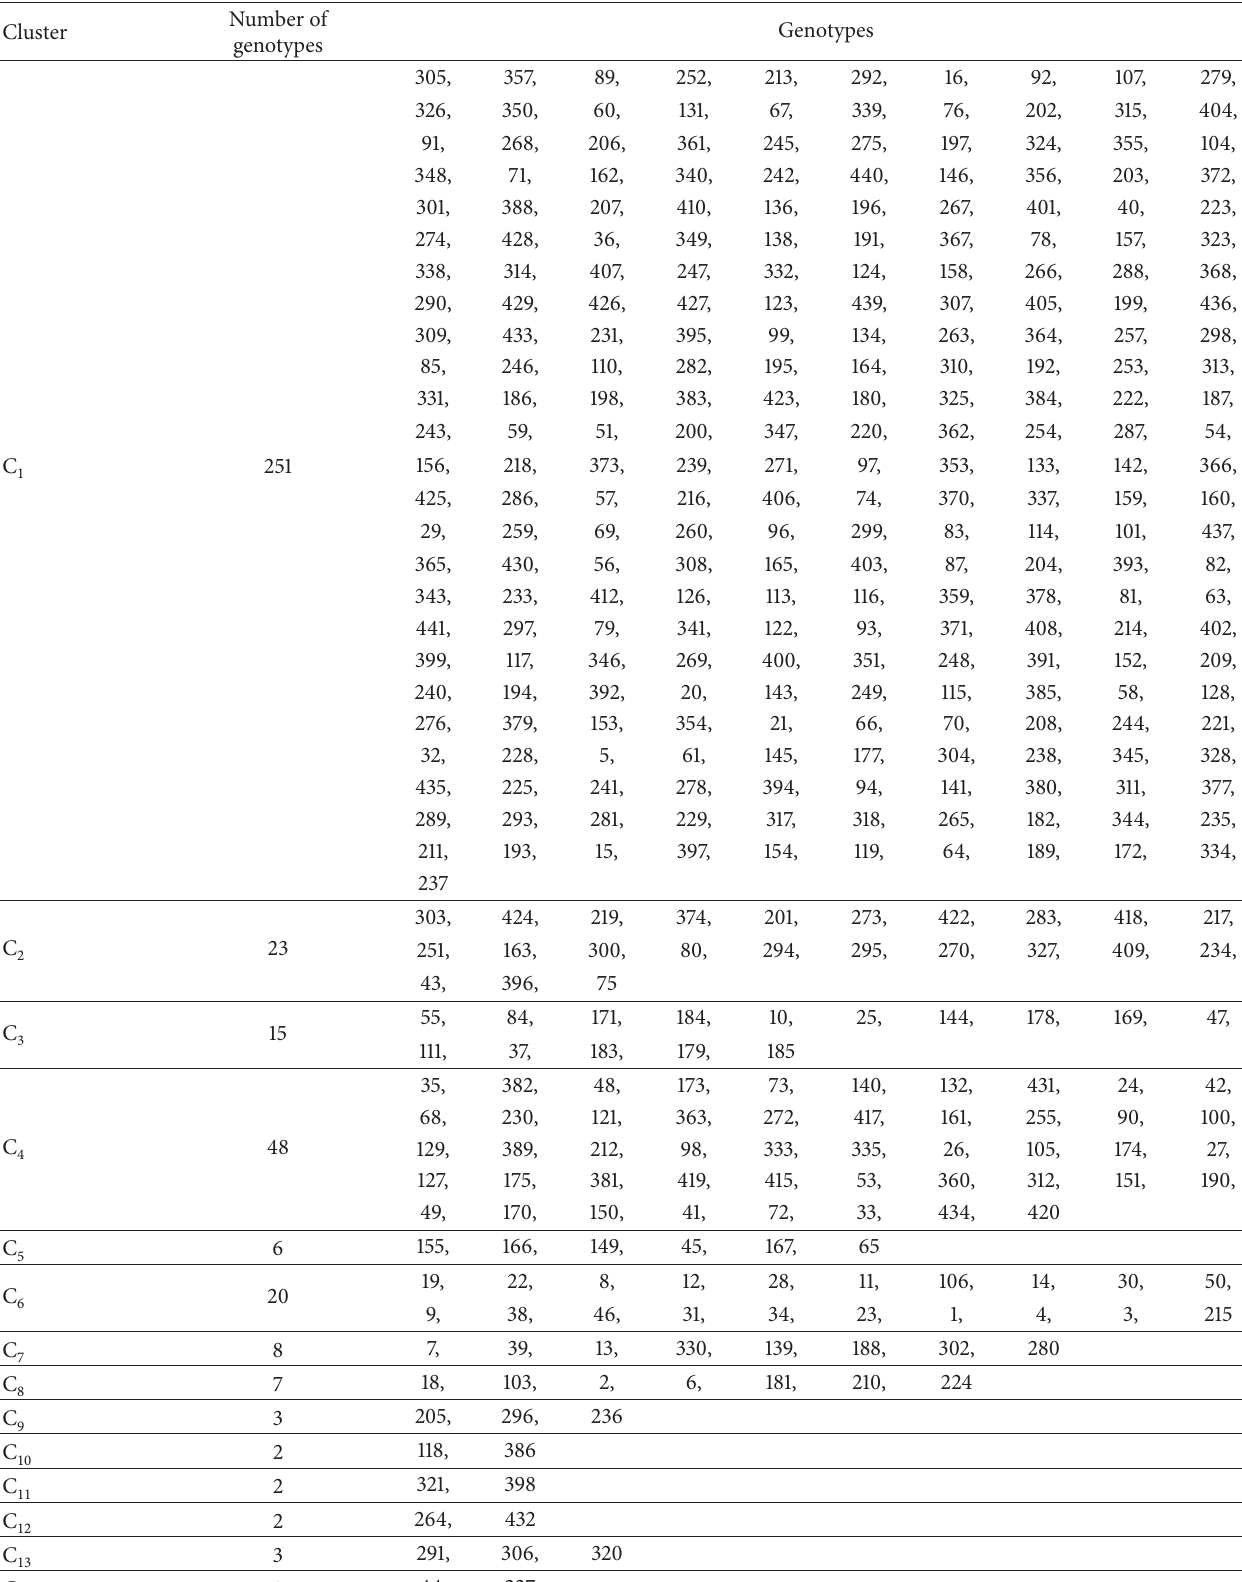
Table 4: Clustering of 400 sugarcane genotypes into twenty groups using 16 qualitative characters (numbers refer to code of genotypes ∗ in Supplemental Tables 1 and 2